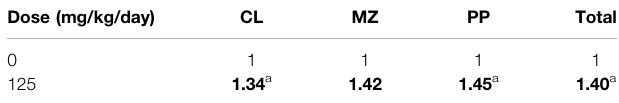
Data are fold change relative to control labeling indices. CL (cid:1) centrilobular, MZ (cid:1) midzonal, PP (cid:1) periportal. Six animals/treatment group were evaluated. Bold values were considered treatment-related